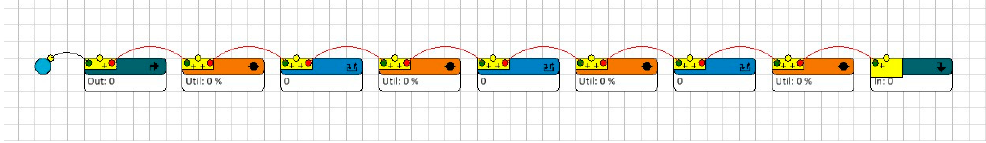
Figure 7. A simulation model with four machines, three buffers, and connected atoms.